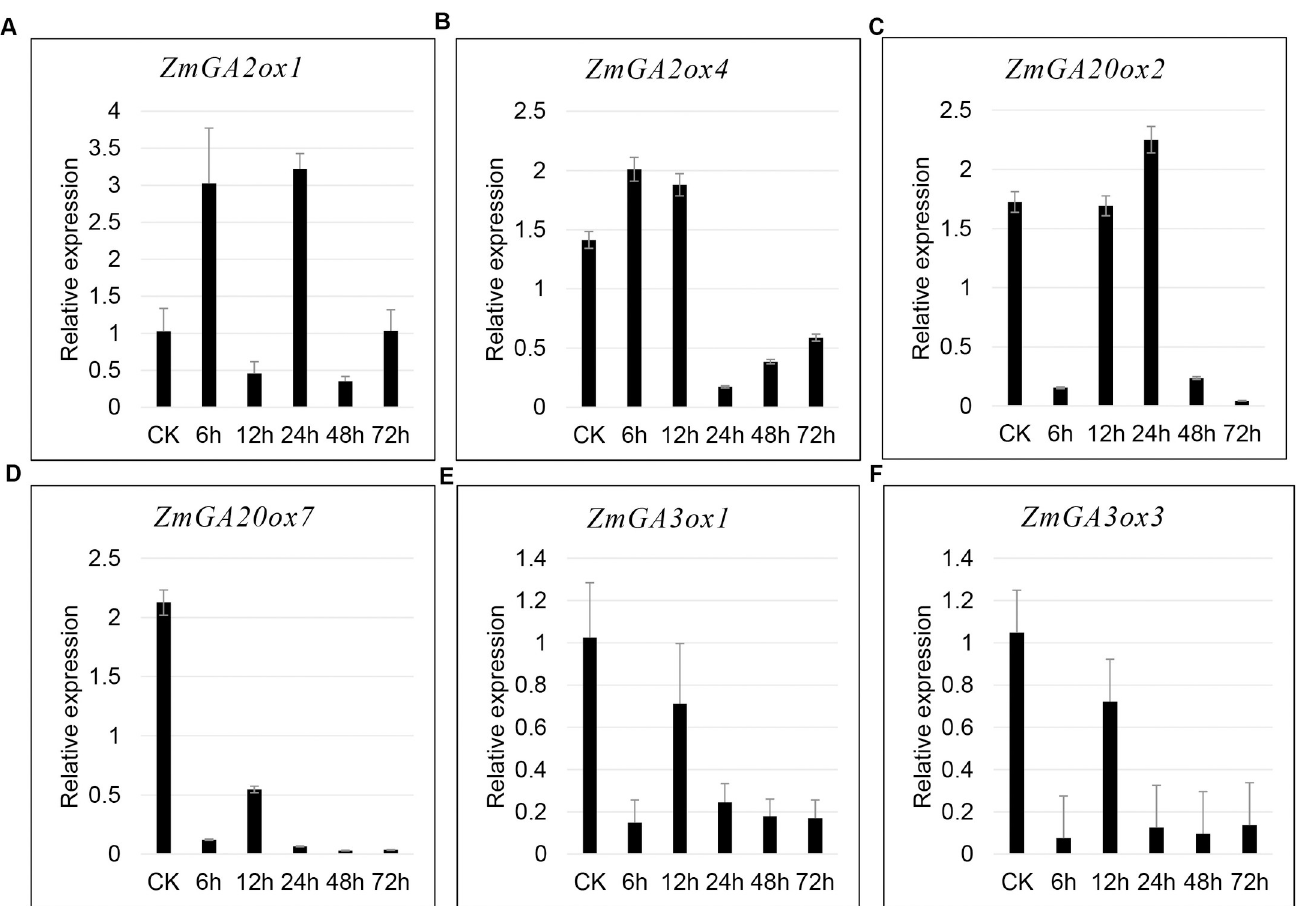
Fig 7. The expression of candidate genes that were most significantly expressed in the response to GA using qRT-PCR analysis. A-F, The expression of Z mGA2ox1 , ZmGA2ox4 , ZmGA20ox7 , ZmGA3ox1 and ZmGA3ox3 after GA treatment, respectively. CK, Control check. �� , p < 0.01, Student’s t-test). Gene expression profiles were evaluated using the 2 - 44 Ct